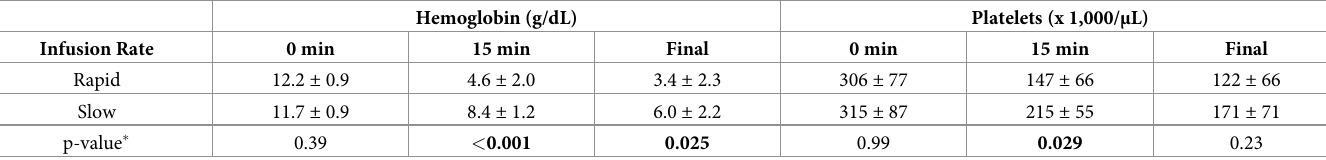
Table 3. Hematologic testing results.